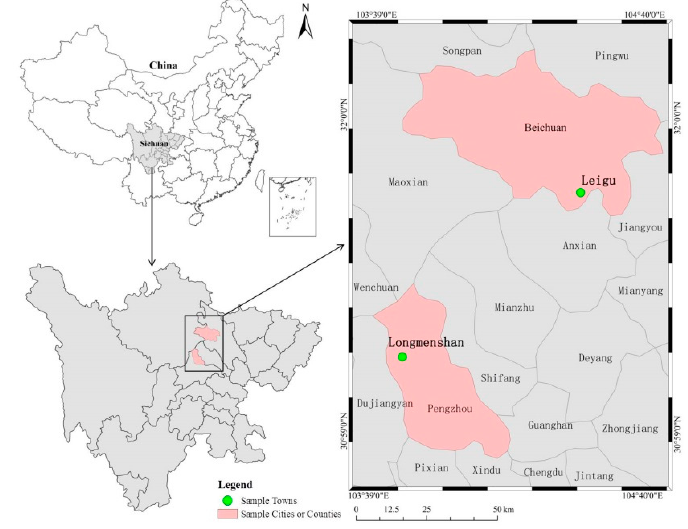
Figure 2. Locations of sample counties (cities) and sample towns.